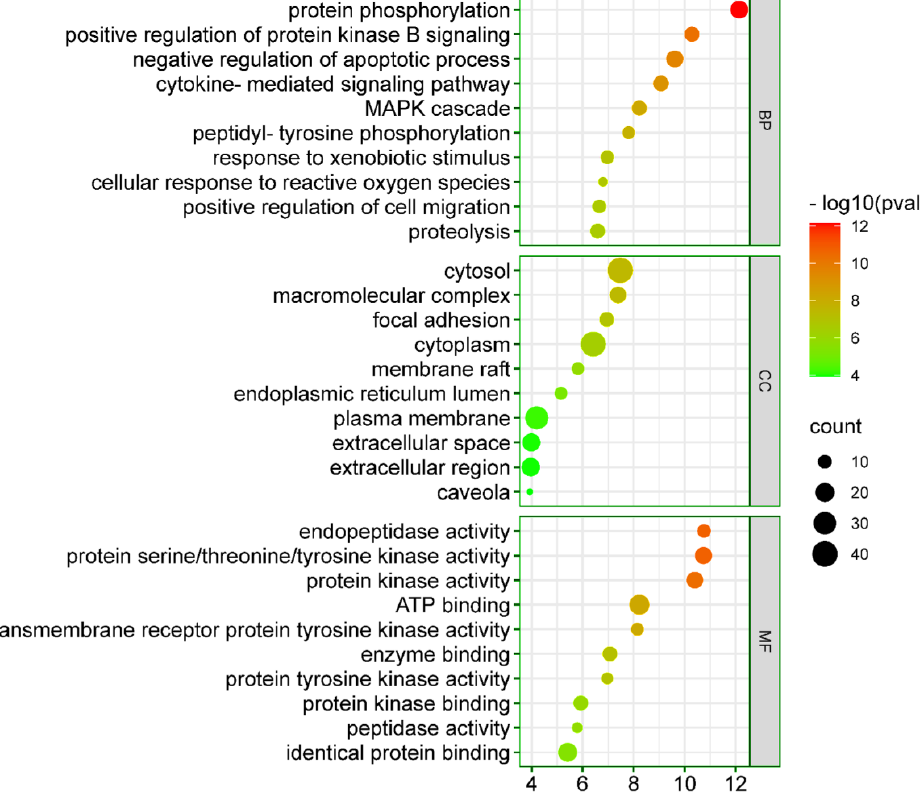
Figure 7. GO enrichment analysis of the 67 intersecting targets for the treatment of HCC with Cnid- ium monnieri